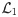
Schematic of the proposed model.An acoustic signal u(t) undergoes a series of transformations starting with a mapping to a time-frequency spectrogram, followed by two-layers of stochastic neural networks (local analysis L1 and long-range analysis L2), then a fusion stage L3.